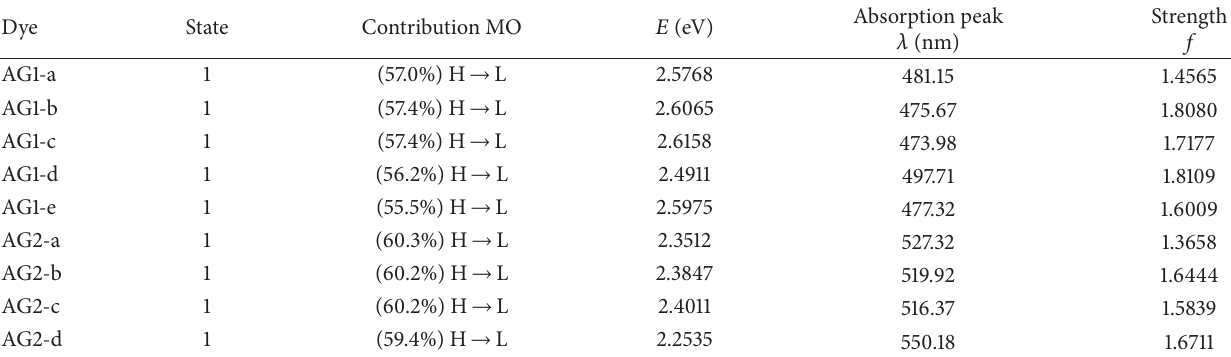
Table 5: Calculated transition energy and oscillator strength designed dyes (AG1-X and AG2-X) in solvent